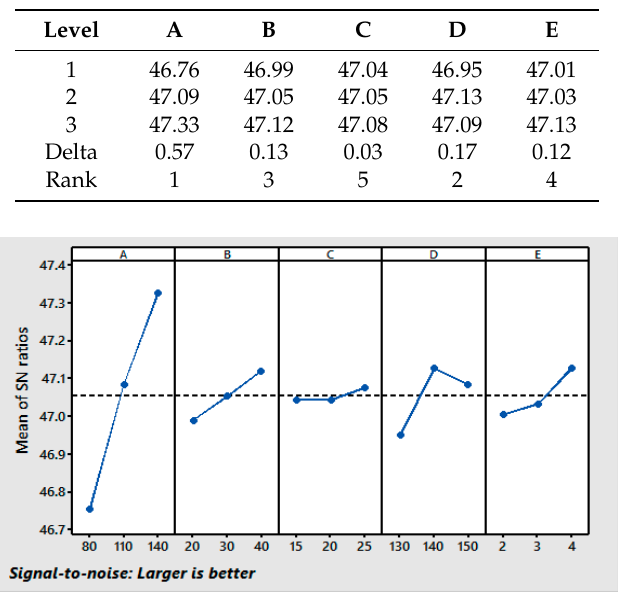
Table 3. Response table for S/N ratios (CRA).